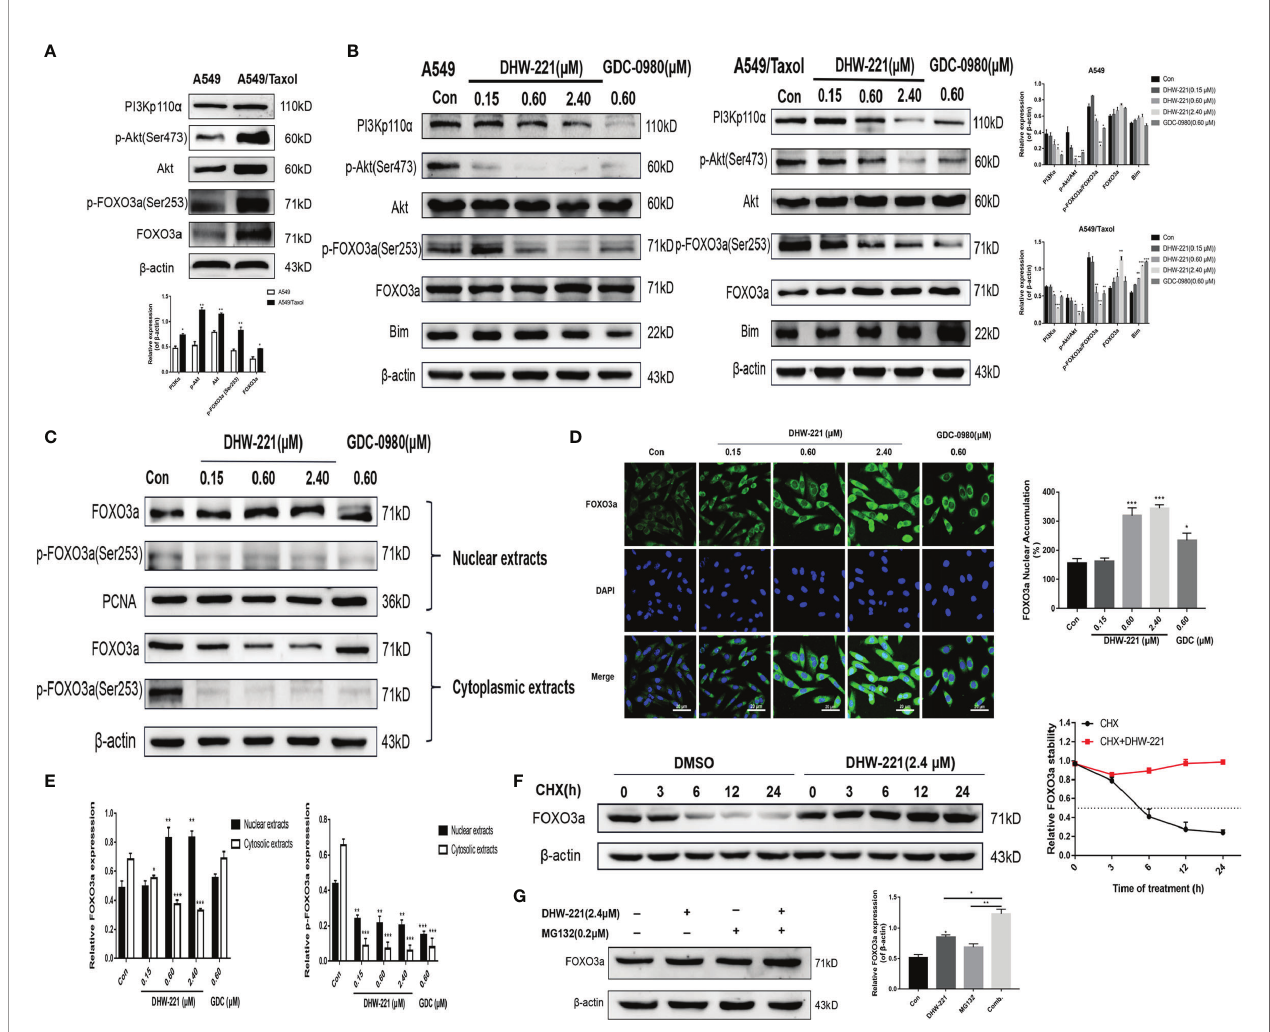
FIGURE 5 | DHW-221-triggered mitochondrial apoptosis is linked to Akt-mediated FOXO3a nuclear translocation in A549/Taxol cells. (A, B) Comparison and the expression levels of PI3K/Akt/FOXO3a signaling pathway related proteins in A549 and A549/Taxol cells were determined by Western blot, in the presence and absence of DHW-221 and GDC-0980. Statistical comparisons were performed with unpaired Student ’ s t-test (n = 3) in Panel (A) . *p < 0.05, **p < 0.01 versus A549. Statistical comparisons were performed with one-way ANOVA followed by Dunnett ’ s post-hoc test for multiple comparisons in Panel (B) (n = 3). *p < 0.05, **p < 0.01, ***p < 0.001 versus control. (C, E) The FOXO3a and p-FOXO3a expressions in the nuclear and cytoplasmic fractions of A549/Taxol cells were detected by Western blot. Proliferating cell nuclear antigen (PCNA) was selected as nucleoprotein internal control. The quantitative results were shown in Panel (E) . (D) Immuno fl uorescence staining of FOXO3a in A549/Taxol cells was carried out to evaluate the effect of DHW-221 on FOXO3a nuclear translocation. Scale bar = 20 µm. The histograms indicated the percentage of the cells in each condition exhibiting FOXO3a nuclear mean fl uorescence intensity (positive cells, green fl uorescence) by ImageJ. (F) FOXO3a degradation in A549/Taxol cells with or withoutDHW-221 co-treatment in different time spot when protein biosynthesis was blocked with 20 µMcycloheximide(CHX). FOXO3a stability was analyzed relative to control byImageJ software. (G) FOXO3a proteins levels inthe presence of MG132 (0.20 m M) or 2.40 m M DHW-221-treated A549/Taxolcells at 24 h. Statistical comparisonswere performed with one-way ANOVA followed byDunnett ’ s post-hoc testfor multiplecomparisons (n= 3). Data were presented as mean ± SD. *p< 0.05, **p < 0.01, ***p < 0.001